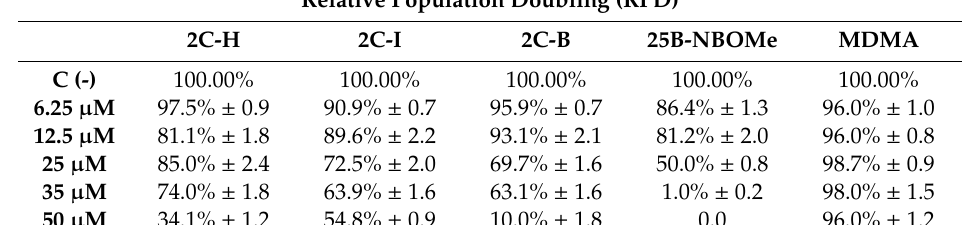
Table 1. RPD on TK6 cells after 26 h treatment with 2C-H, 2C-I, 2C-B, 25B-NBOMe and MDMA at the indicated concentrations with respect to the untreated control C (-). Data are presented as the mean ± the SEM of five independent experiments.